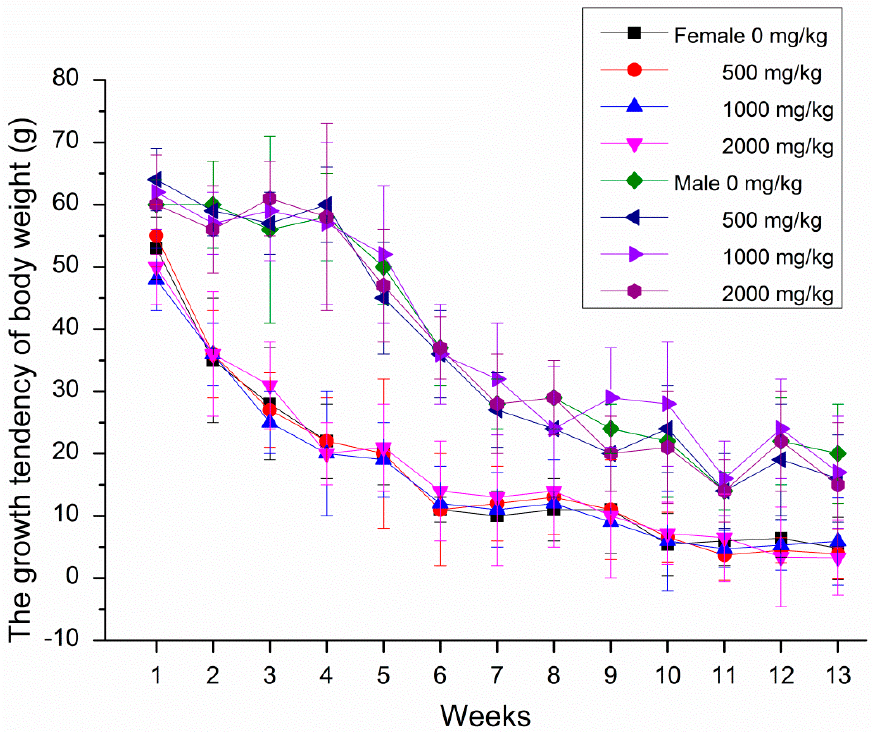
Figure 5. Growth tendency of body weight of rats per week treated with GBP for 91 days.